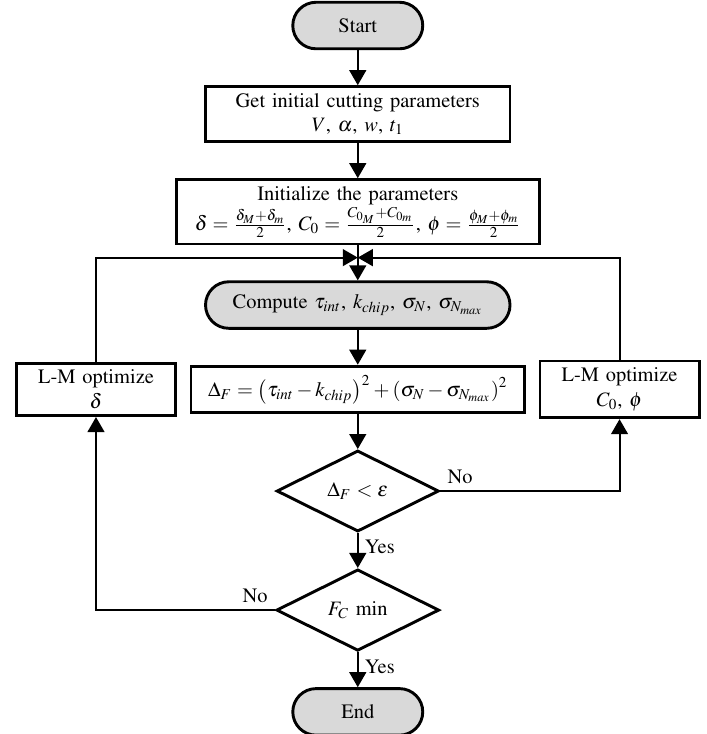
Figure 4. General flowchart of the proposed Oxley–LMFIT